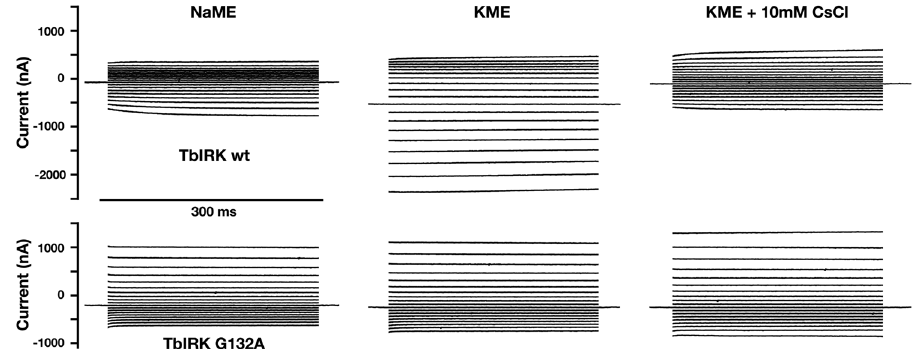
Figure 4. Loss of selectivity upon mutation of G132A located in the suspected selectivity filter. All recordings were done by applying the voltage-step protocol depicted in Fig. 2E. Representative current traces obtained from TbIRK-expressing oocytes in sodium medium (NaME), potassium medium (KME) and potassium medium supplemented with 10 mM CsCl are shown in the upper row. Recordings obtained with a oocyte expressing the G132A-mutant are shown in the lower